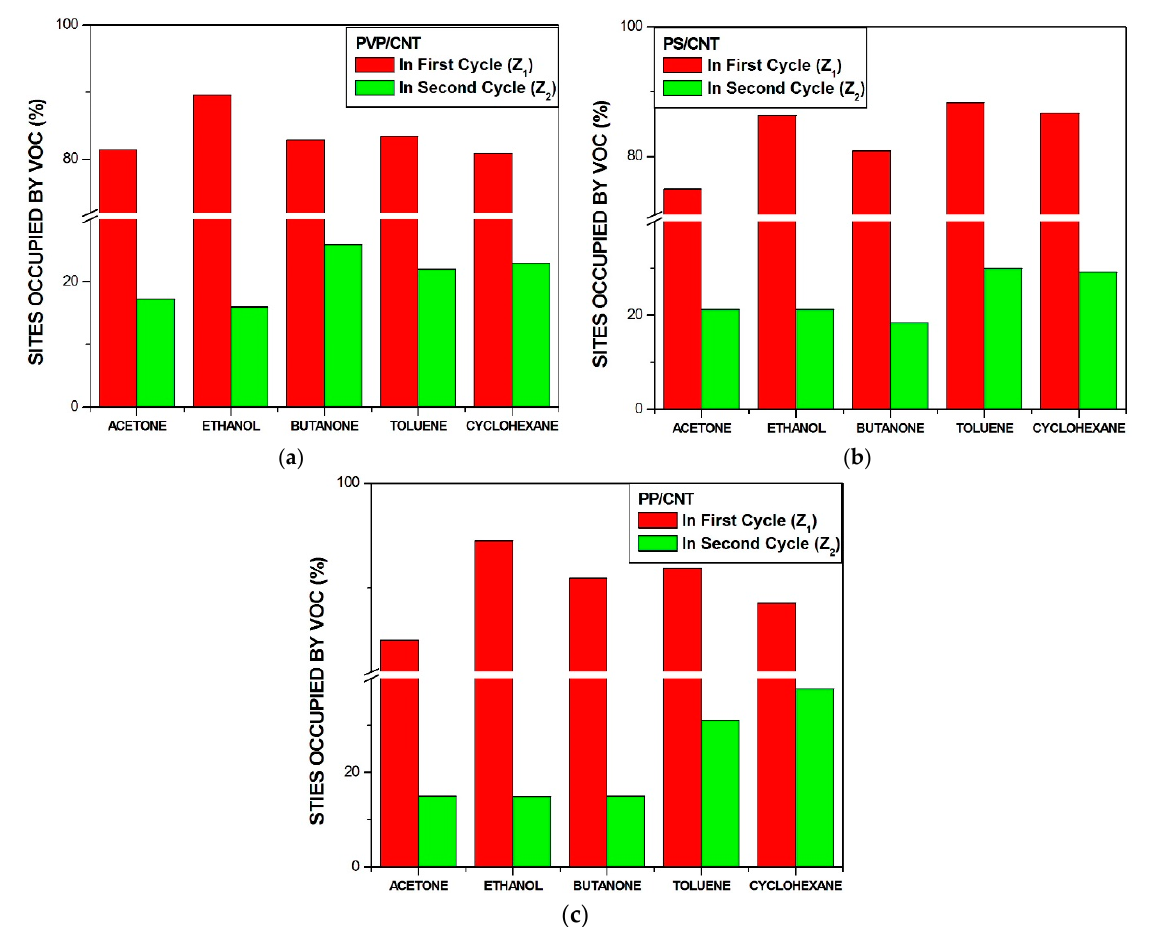
Figure 6. Comparison of percentage of active sites occupied by VOC molecules before and after the adsorption of water molecules: ( a ) for PVP-CNT sensor, ( b ) PS-CNT sensor, and ( c ) PP-CNT sensor.